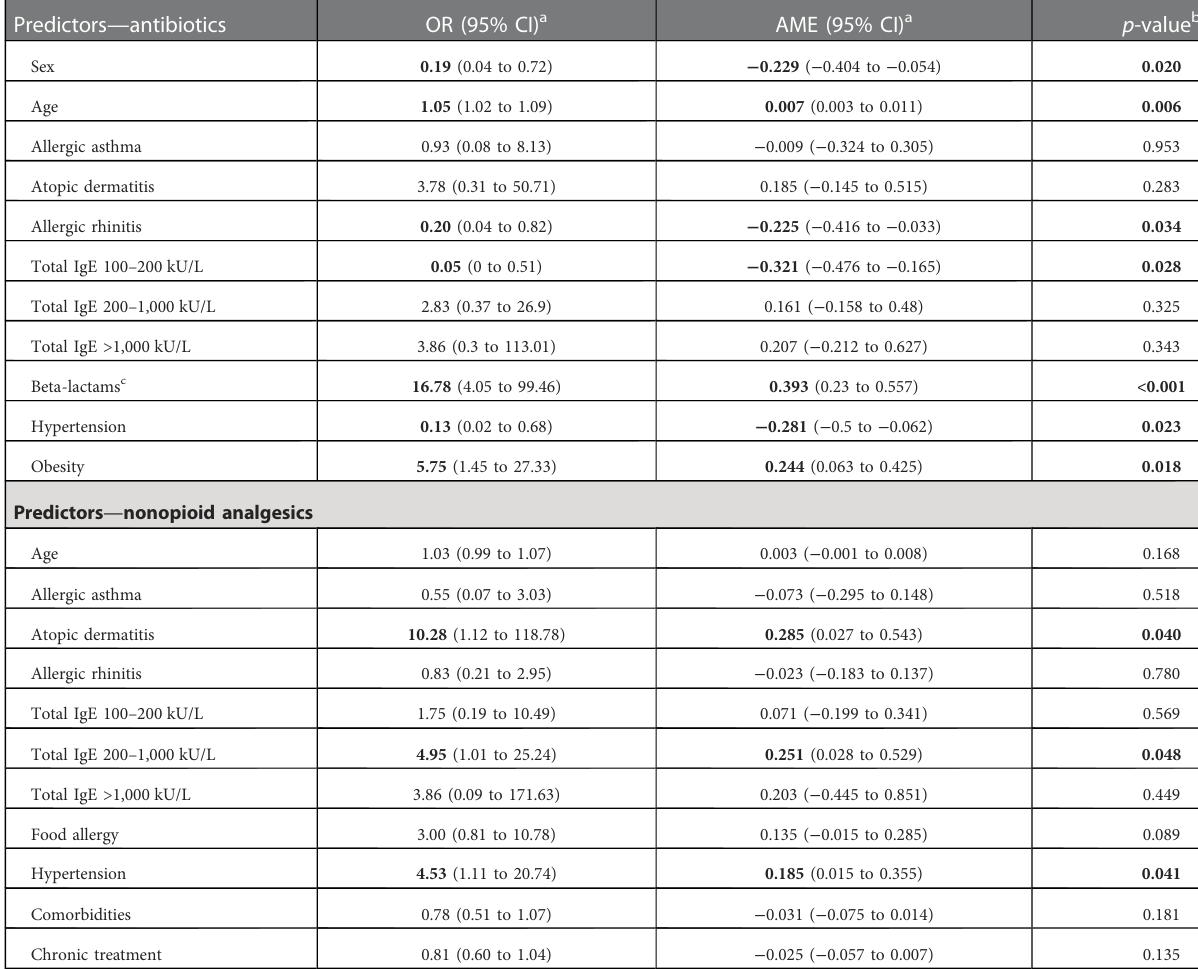
TABLE 1 Identi fi ed cofactors associated with antibiotic hypersensitivity diagnosis. Predictors —